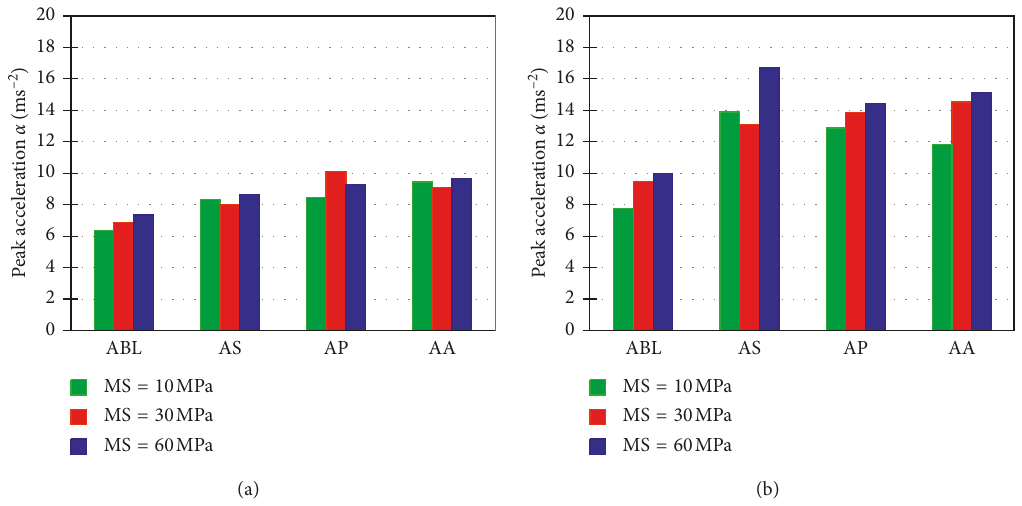
Figure 21: The effect of pebble layer compaction on peak horizontal acceleration a . (a) PGA � 0.2g. (b) PGA � 0.6g.